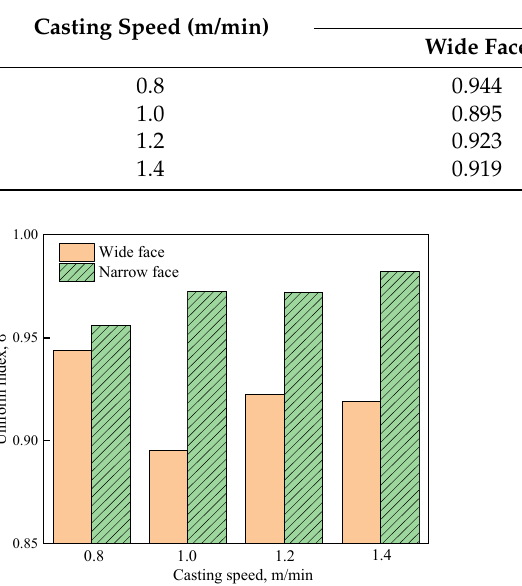
Table 4. Uniform index at z = − 0.4 m under different casting speeds.